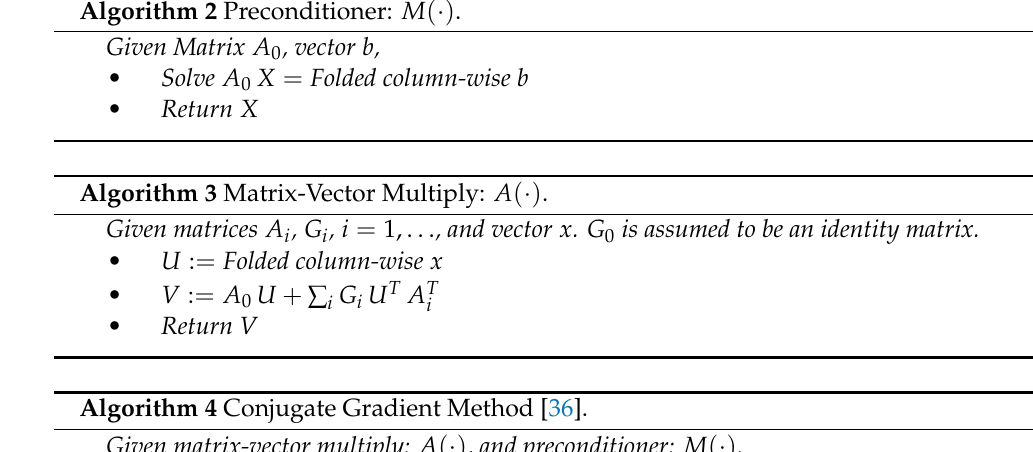
Algorithm 4 Conjugate Gradient Method